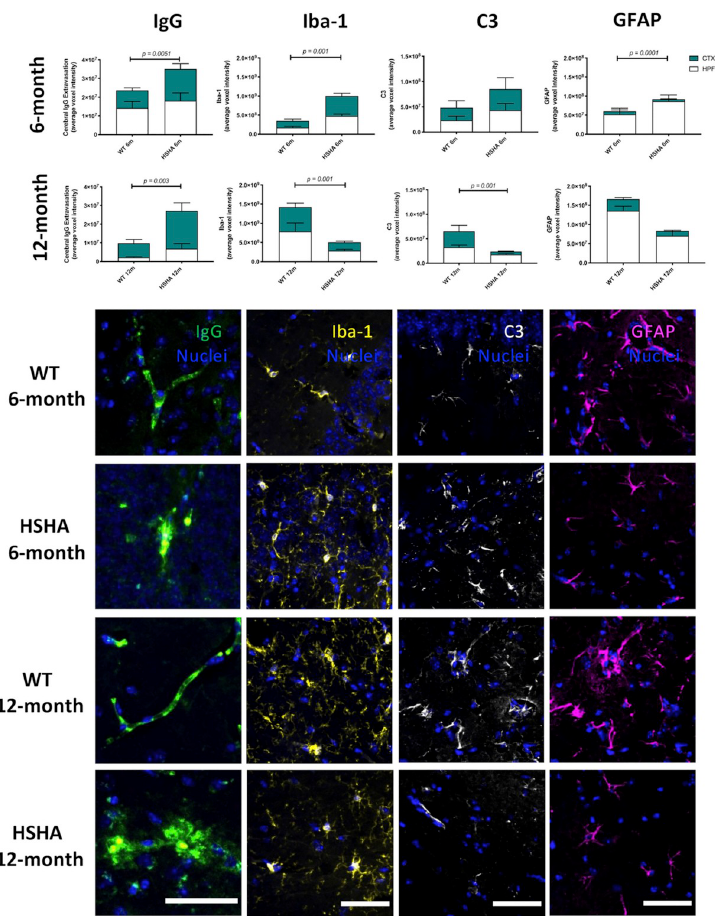
Fig 5. Three-dimensional confocal immunomicroscopy analysis of markers of cerebral capillary integrity, microglial activation, and astrocytic immunoreactivity. Increased cerebral capillary permeability, activated microglia, A1 reactive astrocytes, and activated astrocytes were assessed by the quantitative immunoreactivity of cerebral extravasation of plasma protein IgG, Iba-1, C3, and GFAP, respectively, in the cerebral CTX and HPF of HSHA mice and their age-matched WT controls at 6 (A–D) and 12 months (E–H) of age. The AU : PleaseconfirmthattheedittothesentenceThelatterframes ; whicharerepresentativeconfocalimmunomicrographsofIgG ð green Þ ::: didnotaltertheintendedthoughtofthesentence : latter frames, which are representative confocal immunomicrographs of IgG (green), Iba-1 yellow), C3 (white), and GFAP (magenta), are presented (nuclei are shown as blue; scale bar = 50 μ m). Statistical significance between each strain and age were tested by an unpaired t test with Welch correction testing for nonequivalence of standard deviations. Data are presented as mean ± SEM ( n = 4–12; p -values only indicated for significance). The data underlying Fig 5 A–H can be found in S1 Data. CTX, cortex; C3, complement component 3; GFAP, glial fibrillary acidic protein; HPF, hippocampal formation; HSHA, hepatocyte-specific human amyloid; Iba-1, ionised calcium-binding adaptor molecule 1; IgG, immunoglobulin G; WT, wild-type.